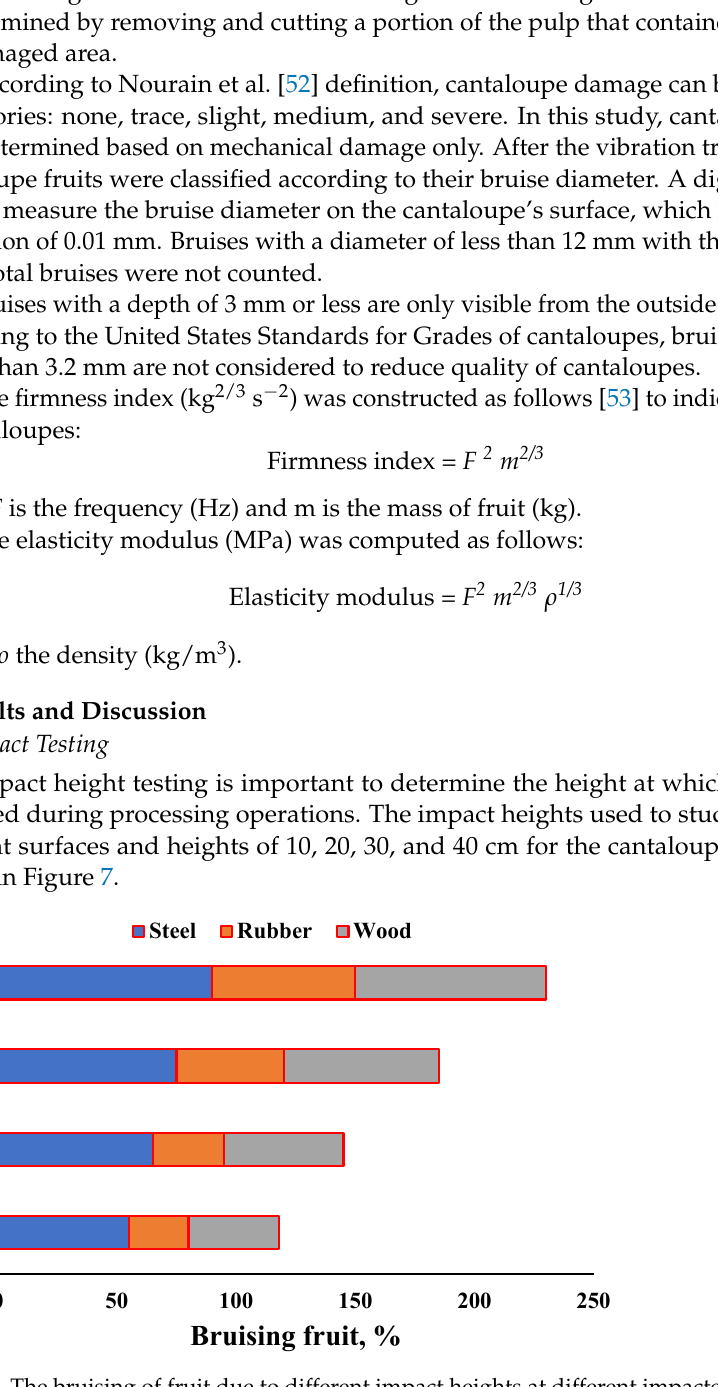
Figure 7. The bruising of fruit due to different impact heights at different impacted surfaces.